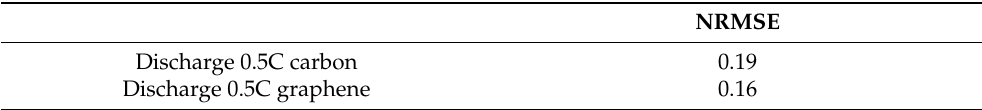
Figure 8. Curves of current versus time for the charge tests with different coating.